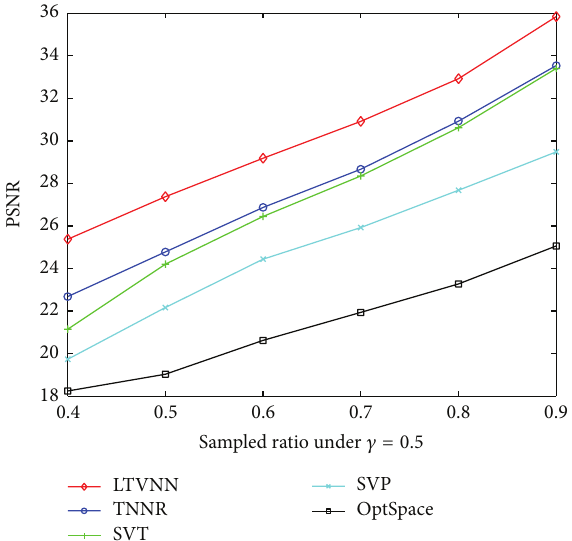
Figure 3: Recovered PSNR for Pepper under 𝛾 = 0.5 with different random sample ratio by LTVNN, TNNR, SVT, SVP, and